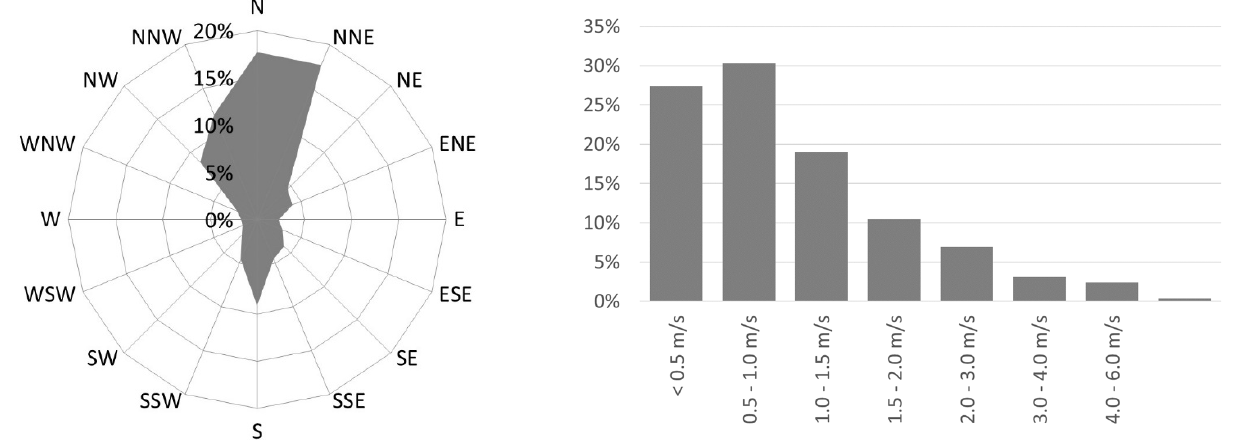
Figure 4. Observed wind–direction and wind–speed frequencies exactly at the times of the field